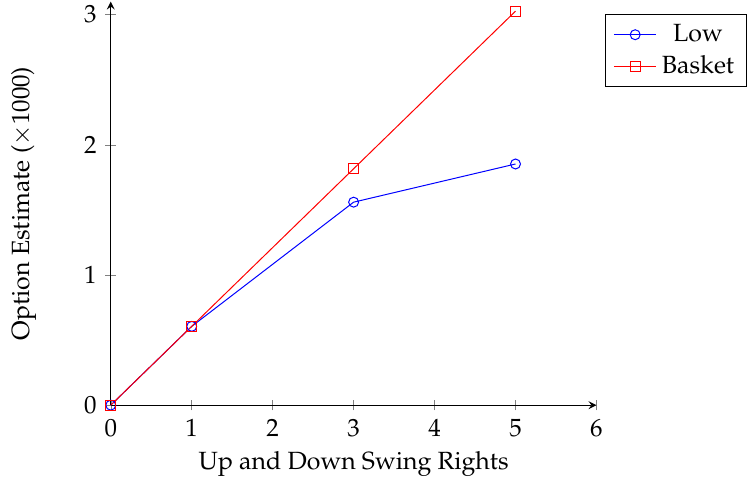
Figure 3. Basket of American calls and puts and swing option values versus the number of exercise rights using a single underlying asset. Parameter values used are exercise volume of 60 units, S 0 = 40, b = 20, R = 4000, m = 5, and no usage